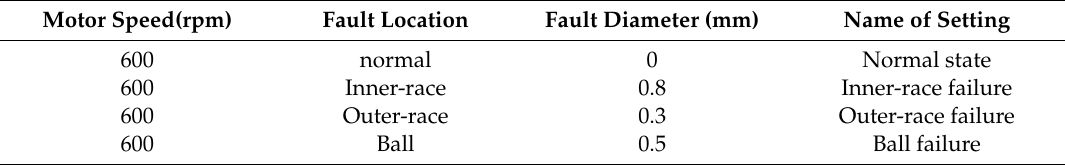
Table 3. Description of dataset in case